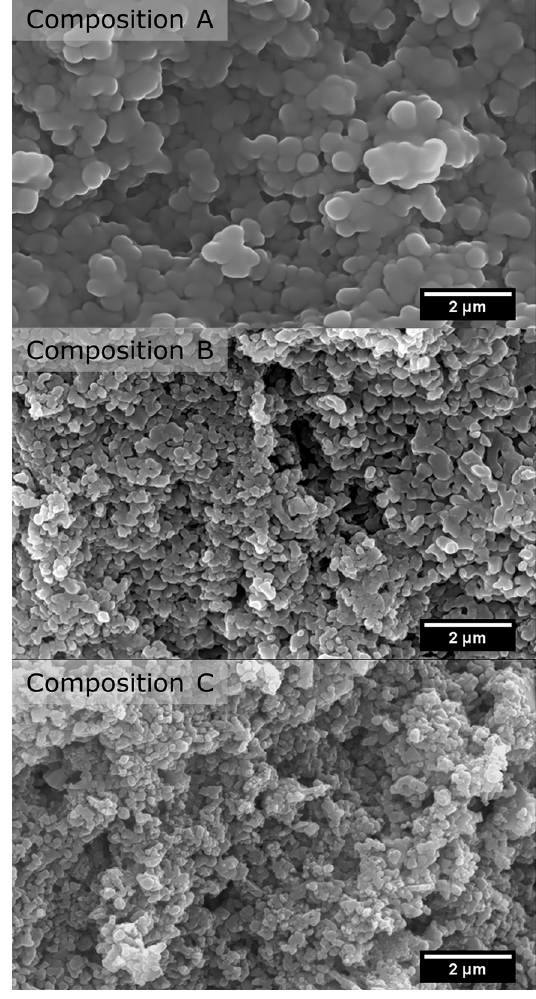
Figure 4. SEM micrographs of fracture surfaces from samples sintered at